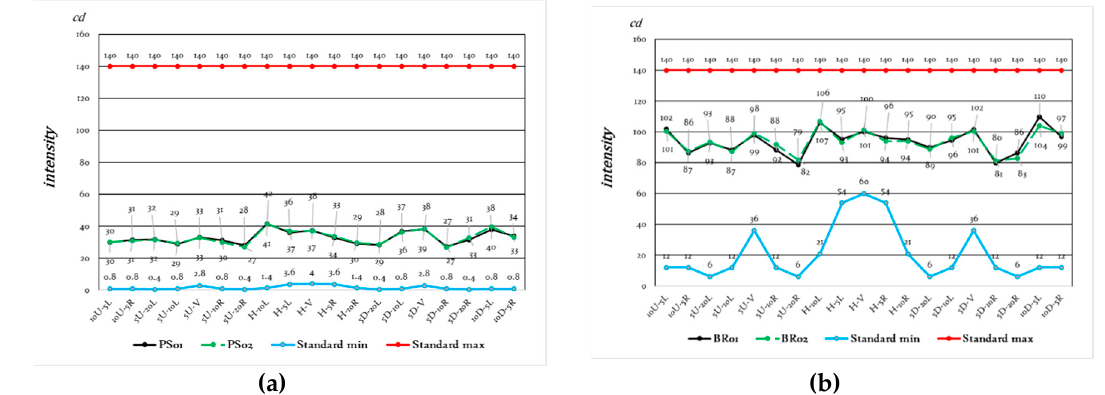
Figure 18. The photometric testing data ( a ) position lamps (PS01, PS02); ( b ) braking lamps (BR01, BR02).